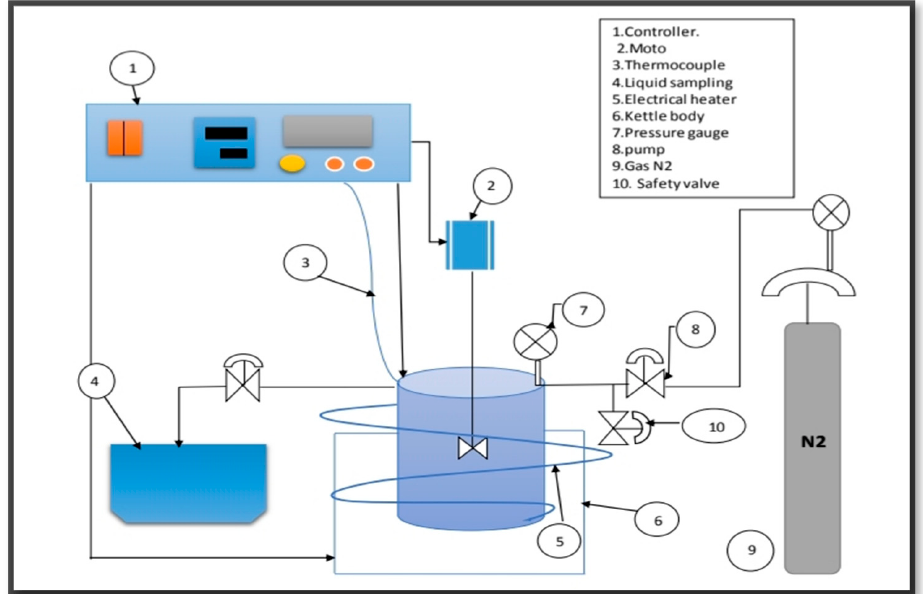
Figure 3. Schematic diagram of the used batch reactor.